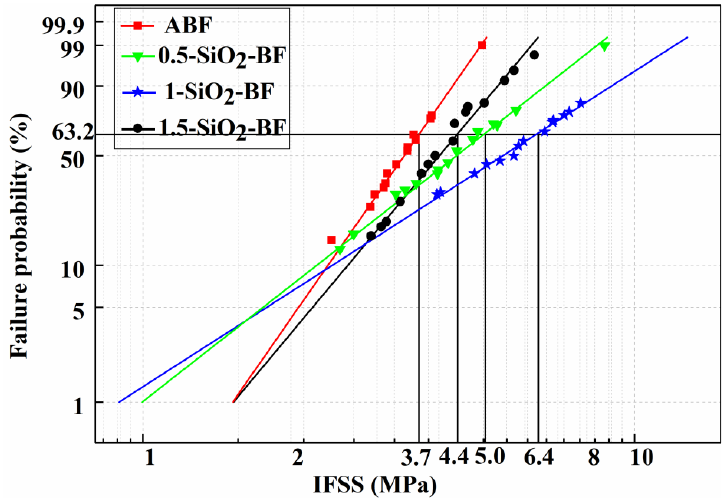
Figure 5. IFSS of fiber / resin before and after modification.